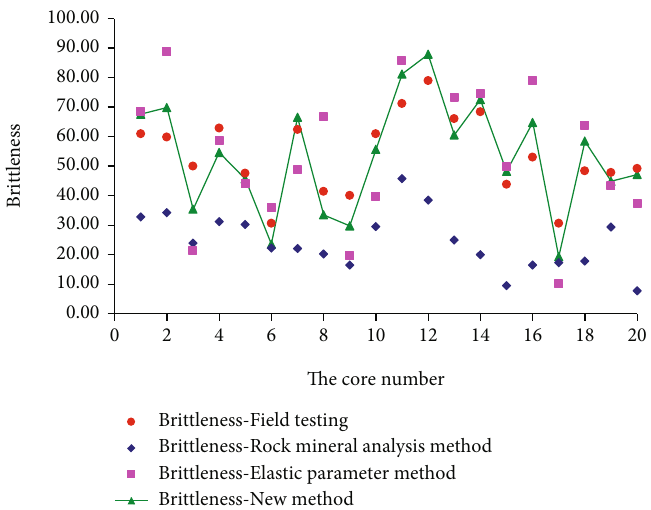
Figure 10: Brittleness results under di ff erent calculation